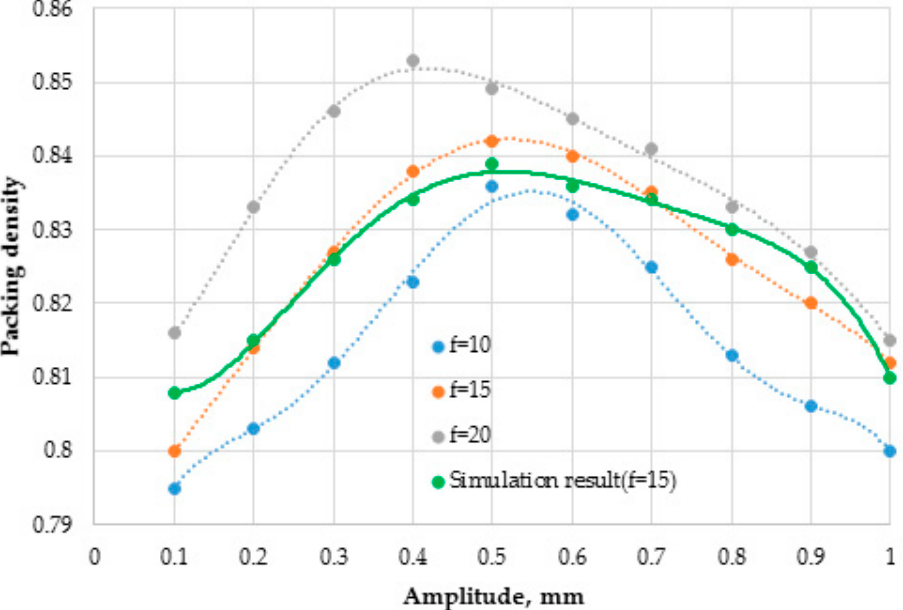
Figure8. E ff ectofamplitudeonpackingdensityofpowderswithGaussiandistribution(average particle Figure 8. Effect of amplitude on packing density of powders with Gaussian distribution (average diameter of 30 µ m) at di ff erent particle diameter of 30 μ m) at different frequencies.